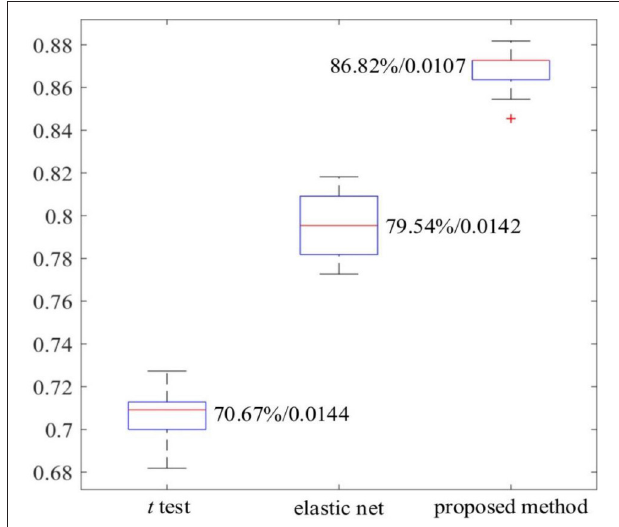
FIGURE 9 | The comparison of three feature selection methods.